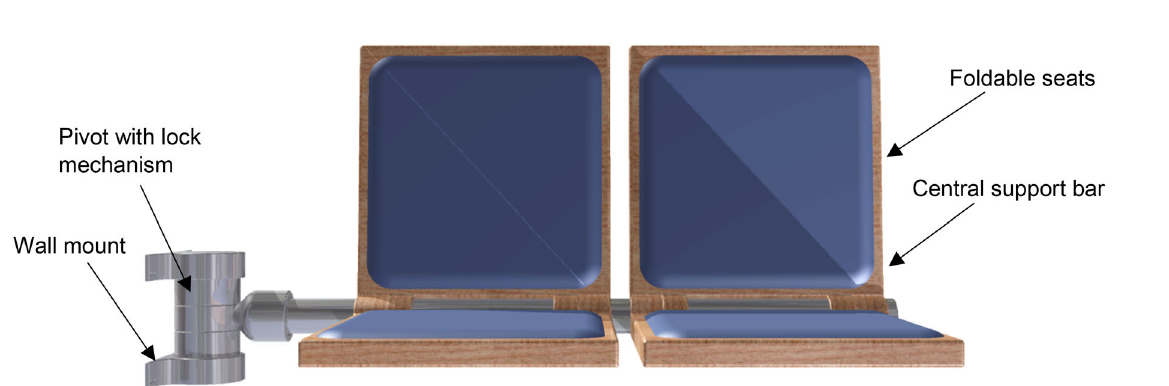
Fig. 15 Transverse folding seat design Fig. 16 Transverse seat design in